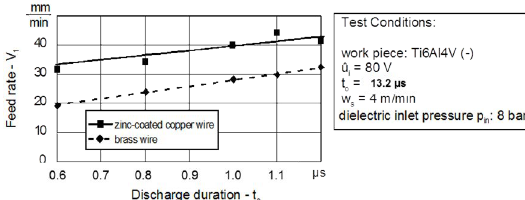
on the wire feed e